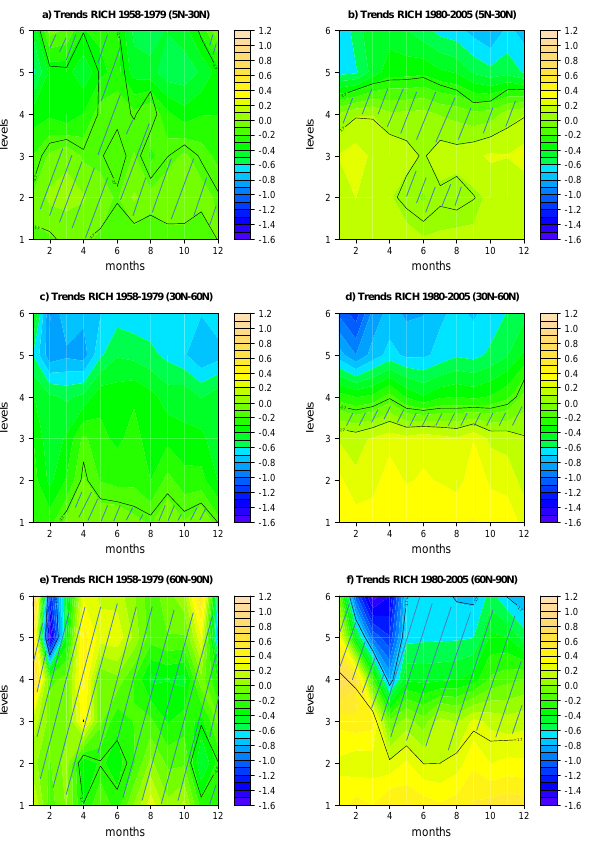
Figure 4 Figure 4. Temperature trends ( ◦ Cdecade − 1 ) for each month ( x axis) and level ( y axis) based on RICH data set over the periods 1958–1979 and 1980–2005, respectively, for three latitudinal belts: (a) and (b) for 5–30 ◦ N, (c) and (d) for 30–60 ◦ N and (e) and (f) for 60–90 ◦ N. Level 1: 850hPa, Level 2: 500hPa, Level 3: 300hPa, Level 4: 100hPa, Level 5: 50hPa, and Level 6: 30hPa. The shaded areas are non-statistically significant at the 90% confidence level.